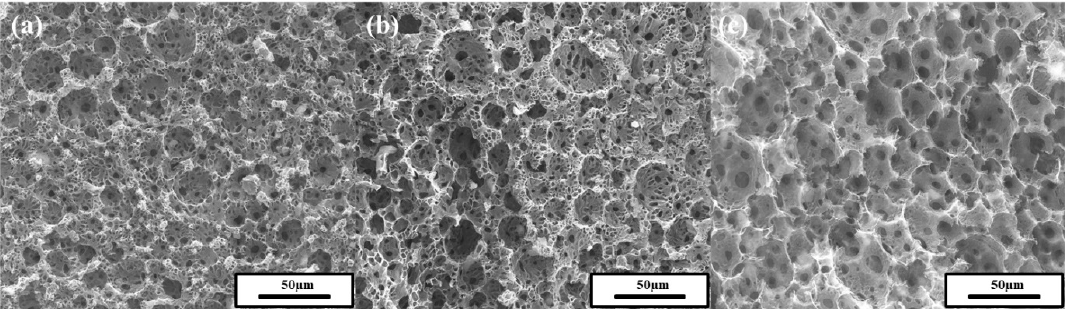
Figure 9. SEM images of polyHIPEs prepared with a 5 wt.% oligoimide particle concentration and 6 wt.% PAAS concentration with internal phase values of ( a ) 75 vol.%, ( b ) 80 vol.%, and ( c ) 85 vol.%.